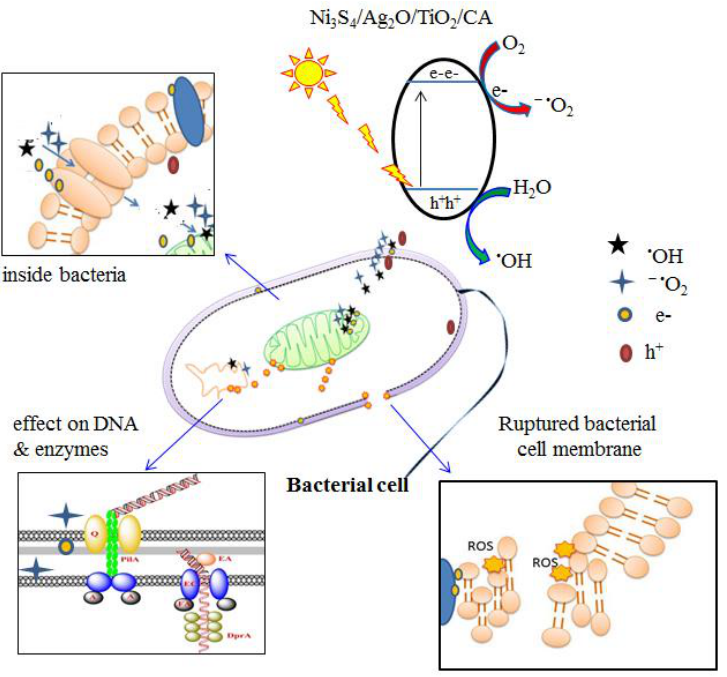
Figure 15. A proposed mechanism for the decontamination of the microbes using Ni 3 S 4 /Ag 2 S/TiO 2 /CA aerogel in dark and solar